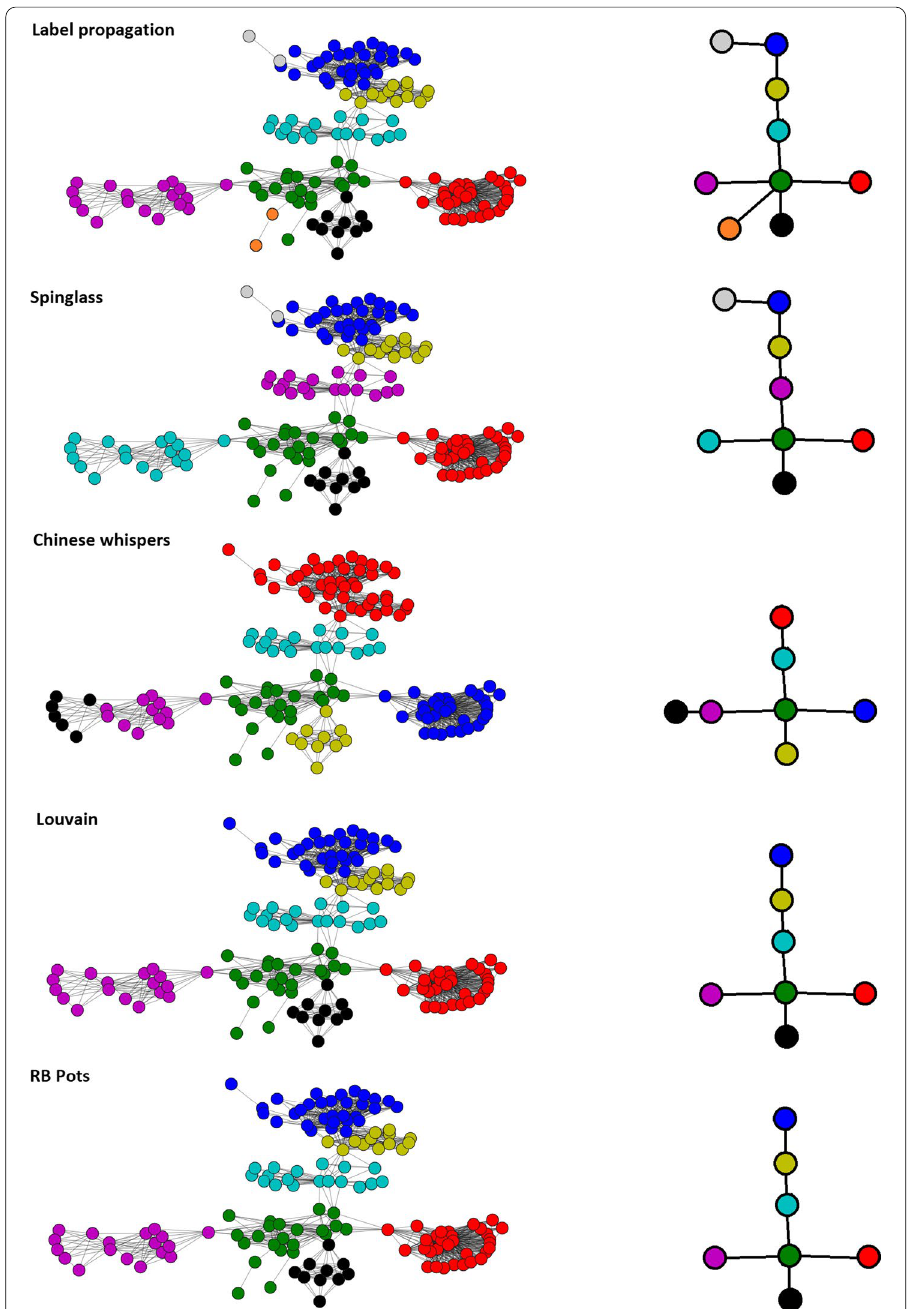
Fig. 4 Community formed with label propagation, spinglass, Chinese whispers, Louvain, and RB Pot algorithm (left). Connection between community on every algorithm (right). Different communities are expressed in different